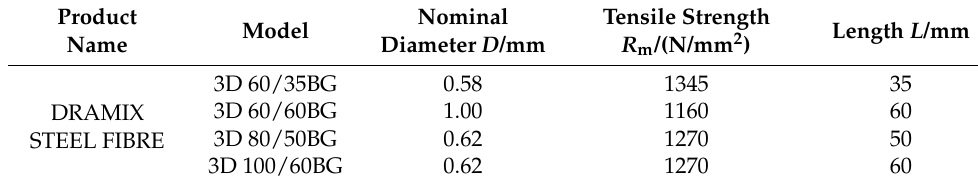
Table 2. Steel fiber parameters.